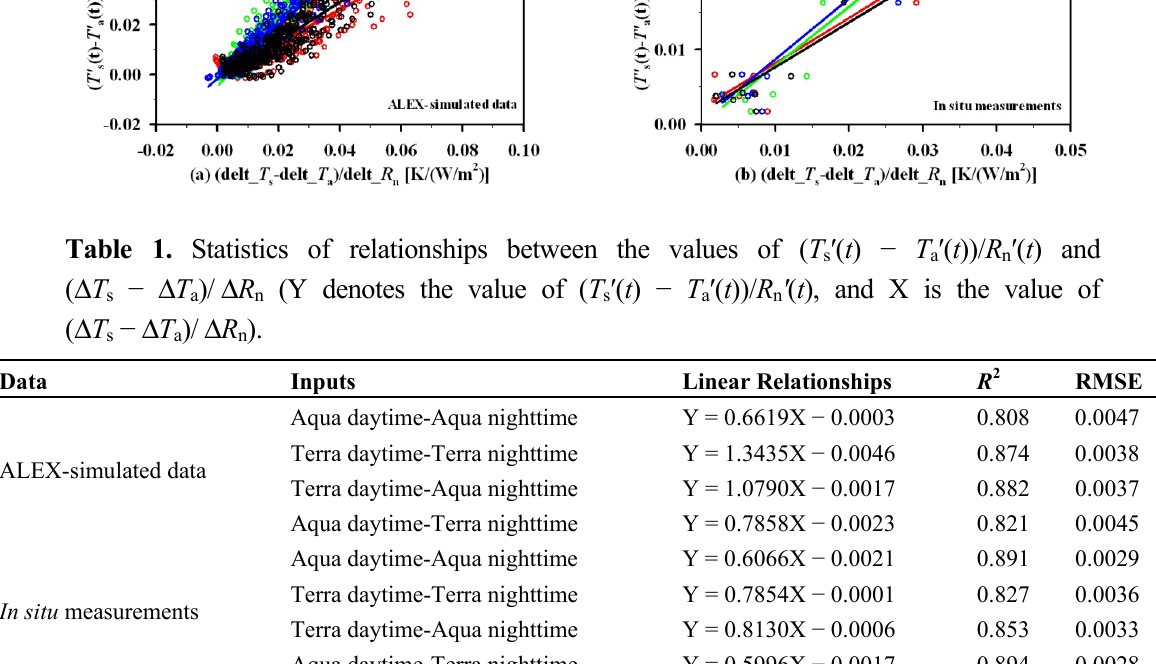
Figure 7. Relationship between the values of ( T ( a ) ALEX-simulated data driven by the atmospheric forcing at the Yucheng station in 2010, and ( b ) in situ measurements at the Yucheng station during the wheat growth period in 2012.